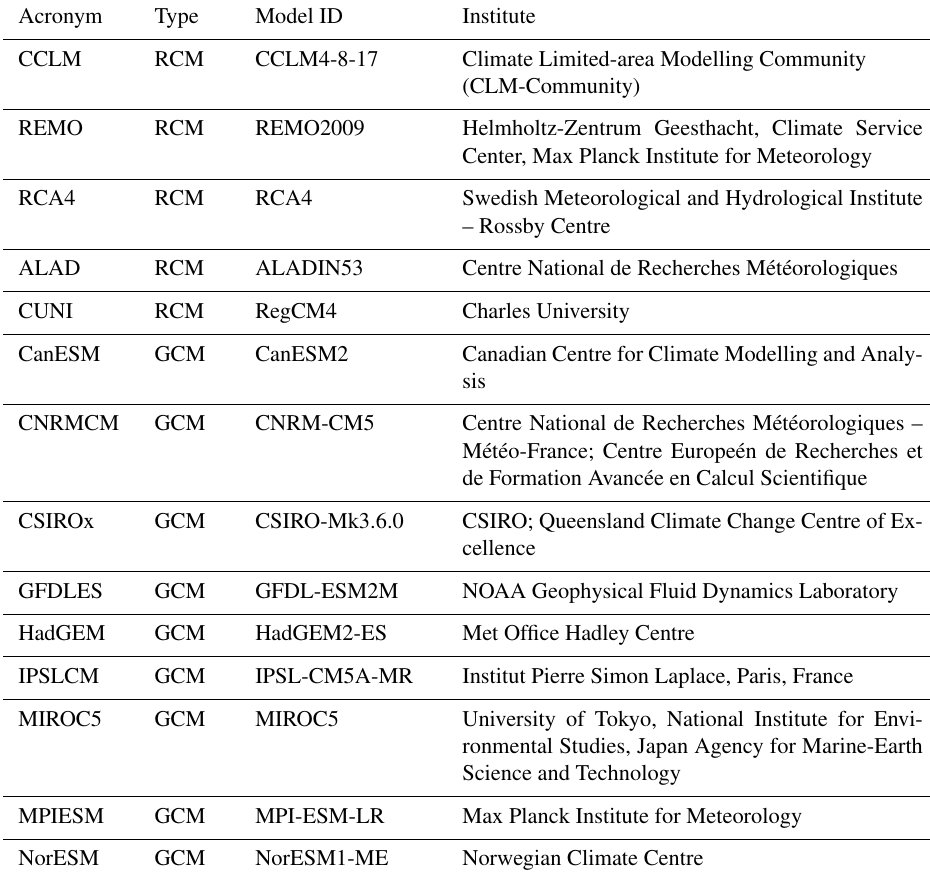
Table 1. List of regional climate models and driving global climate models incorporated in the present study. The first column contains the acronyms used throughout the text. The type column indicates whether the model is regional (RCM) or global (GCM).